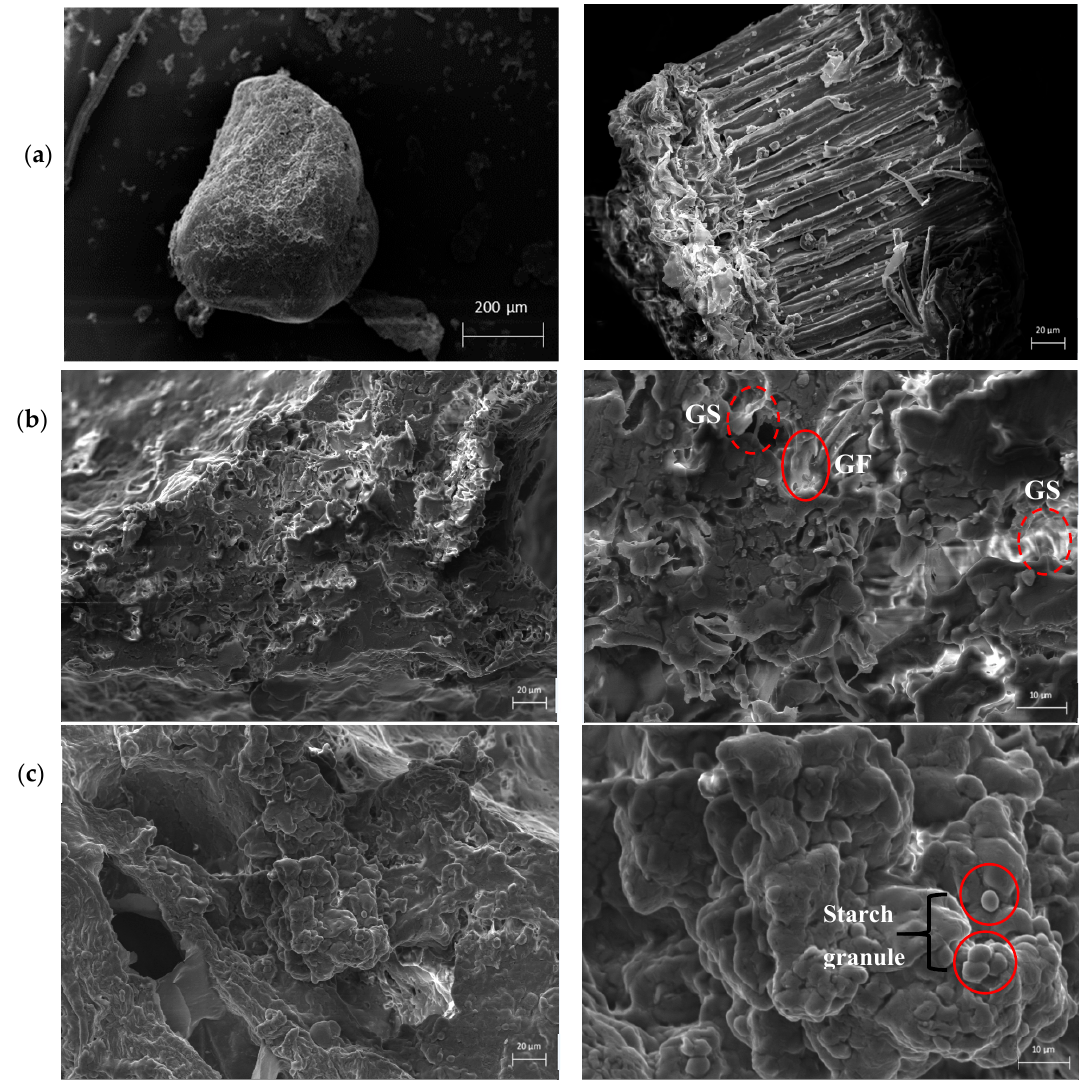
Figure 2. Microstructure of BBH, control breads and 21% BBH fortified bread. Scanning Electron Microscopy (SEM) was carried out at 200× and 1000× magnification in ( a ) BBH; 1000× and 3000× magnification in ( b ) control bread and ( c ) 21% BBH bread. GS, gluten strand; GF, gluten film.